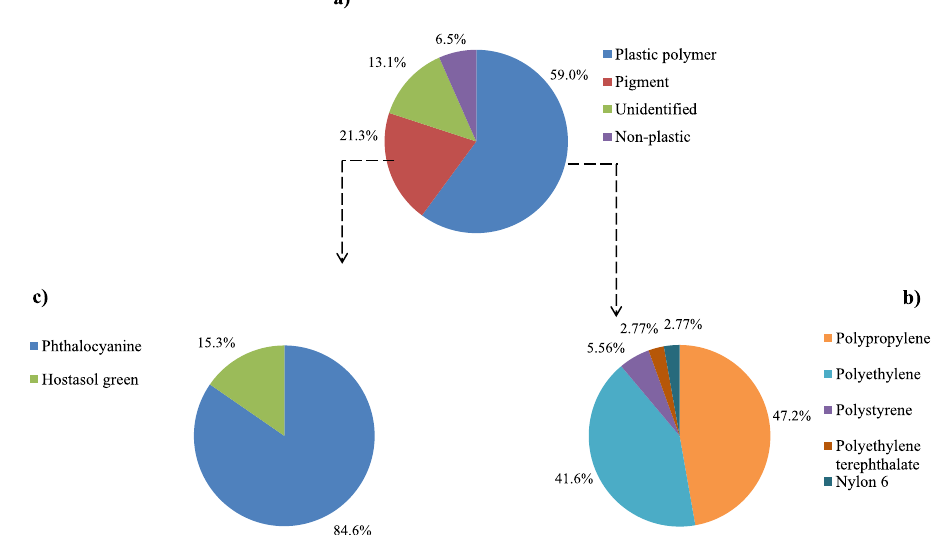
Figure 1. Particle compositions. ( a ) Pie chart of the percentage and chemical composition of the extracted particles from dried fish samples and their corresponding proportion of ( b ) plastic polymers, and ( c ) pigments.